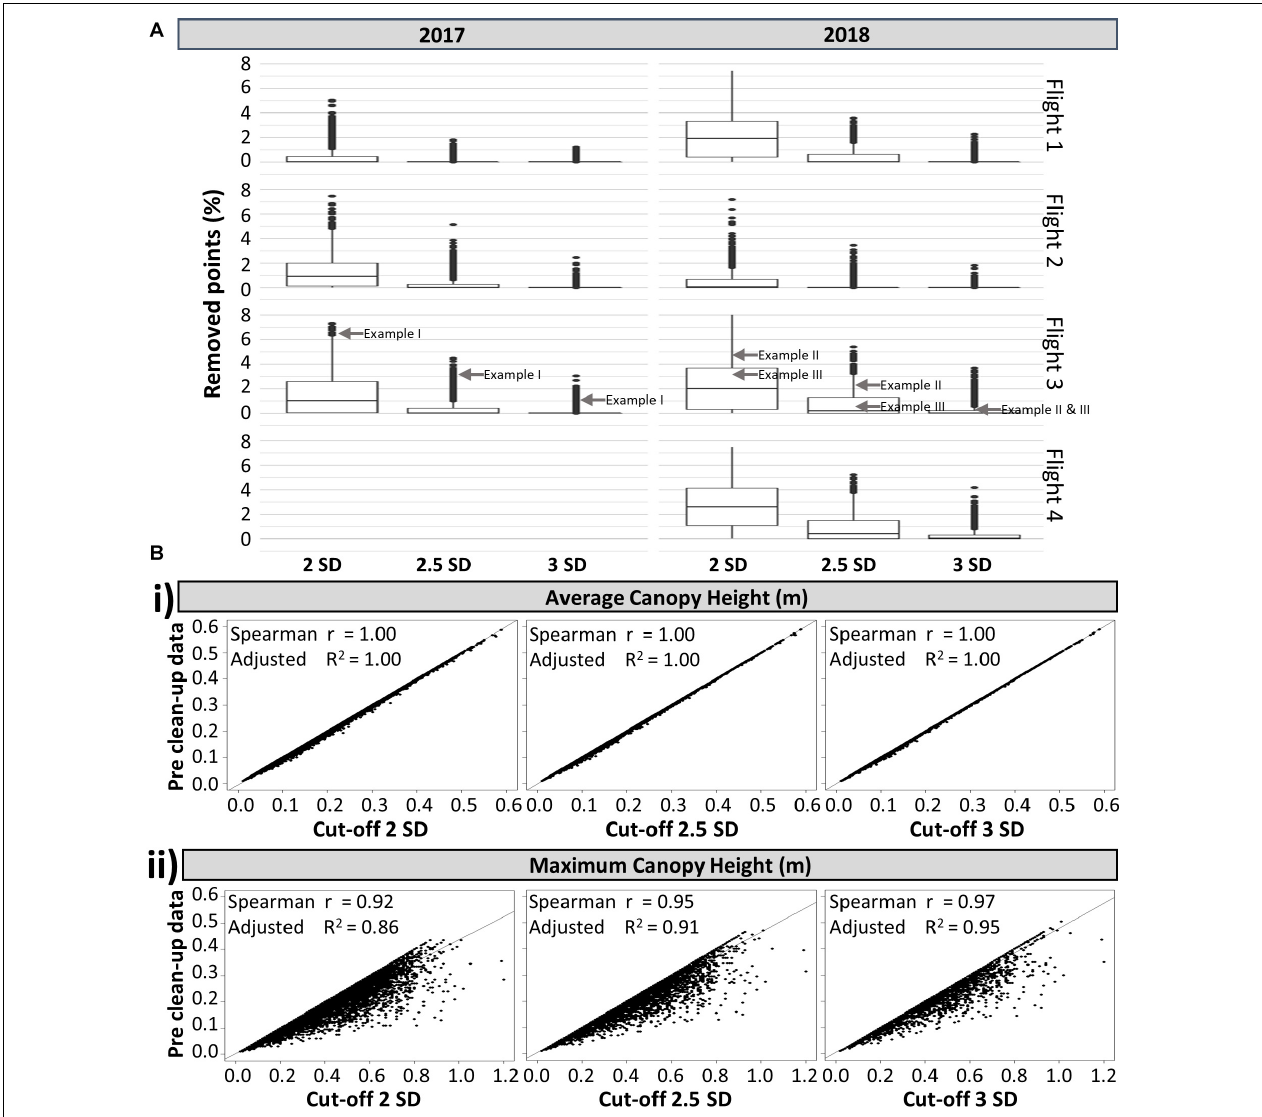
FIGURE 6 | (A) Box-plot of the percentage of points removed from the point cloud of individual plots based on 3 different standard deviation (SD) cut-offs, shown by flight and by year ( n = 8,264). The locations of the exemplar plots shown in Figure 5 are indicated with gray arrows. (B) Relationship between the pre clean up dataset and post clean up dataset using three SD cut-offs, for the: (i) average canopy height and (ii) maximum canopy height. All analyses have a p < 0.01, n =